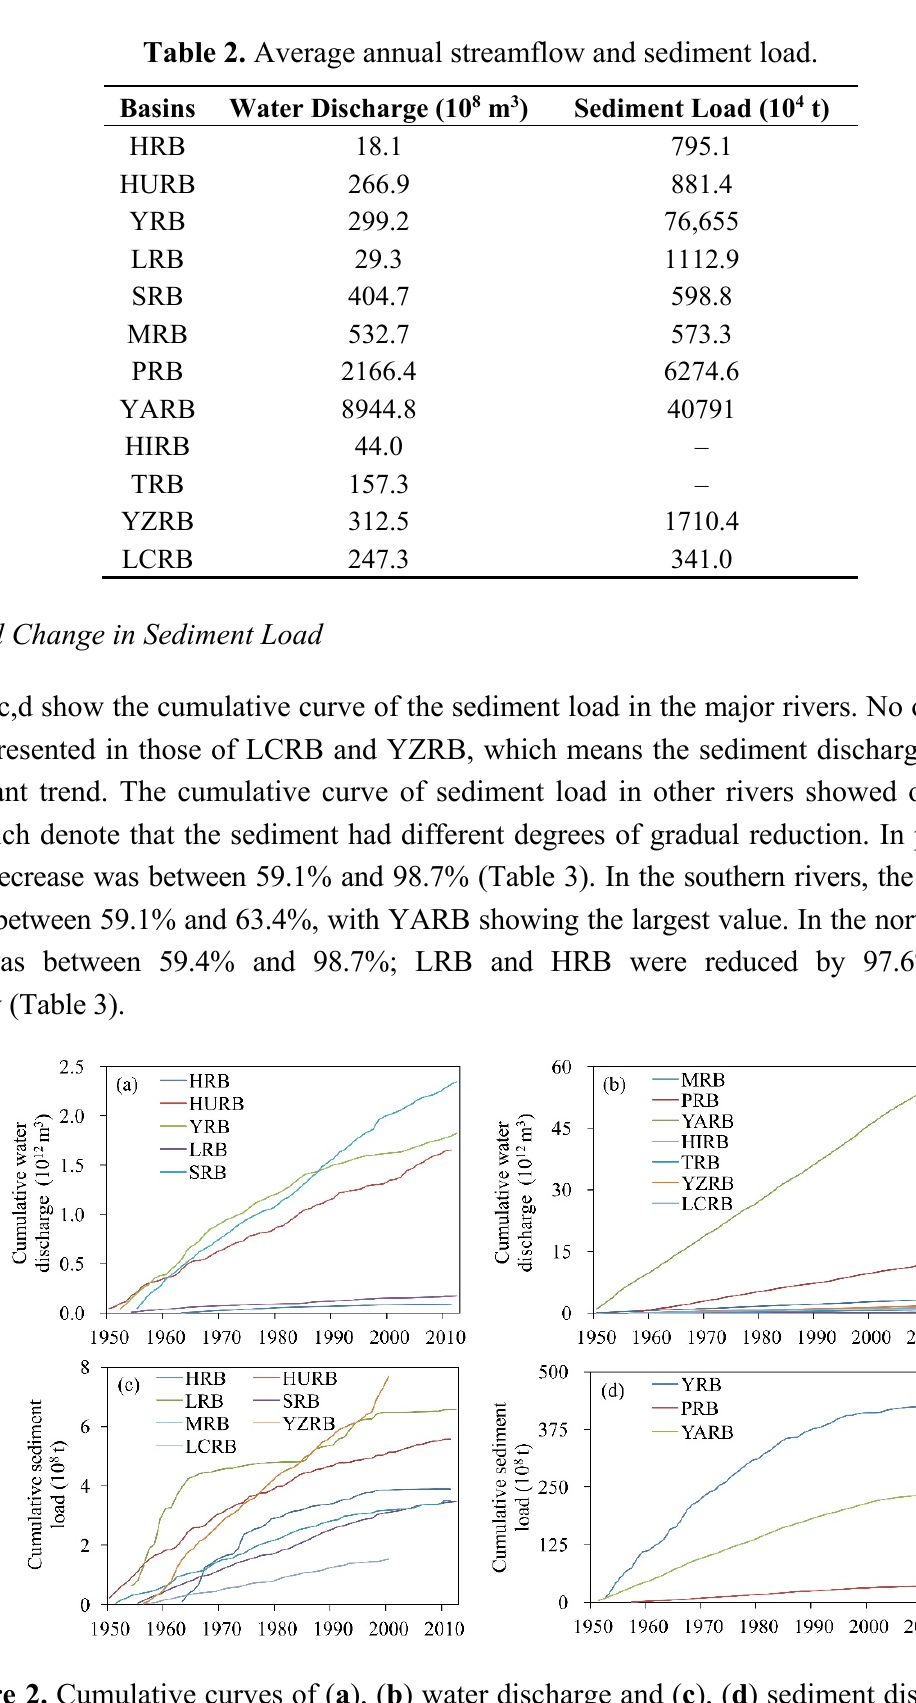
Figure 2. Cumulative curves of ( a ), ( b ) water discharge and ( c ), ( d ) sediment discharge in major basins in China, during